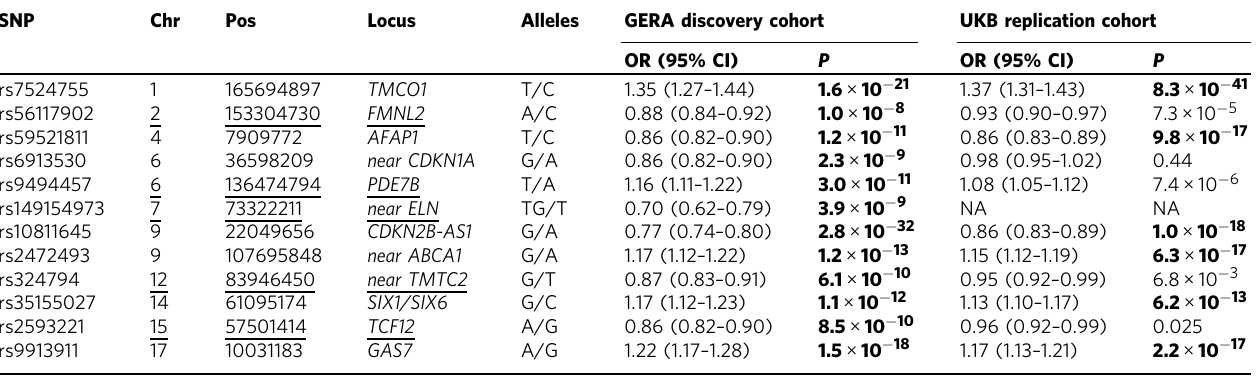
Table 2 Lead genome-wide signi fi cant SNP for each independent locus identi fi ed in the GERA discovery GWAS of